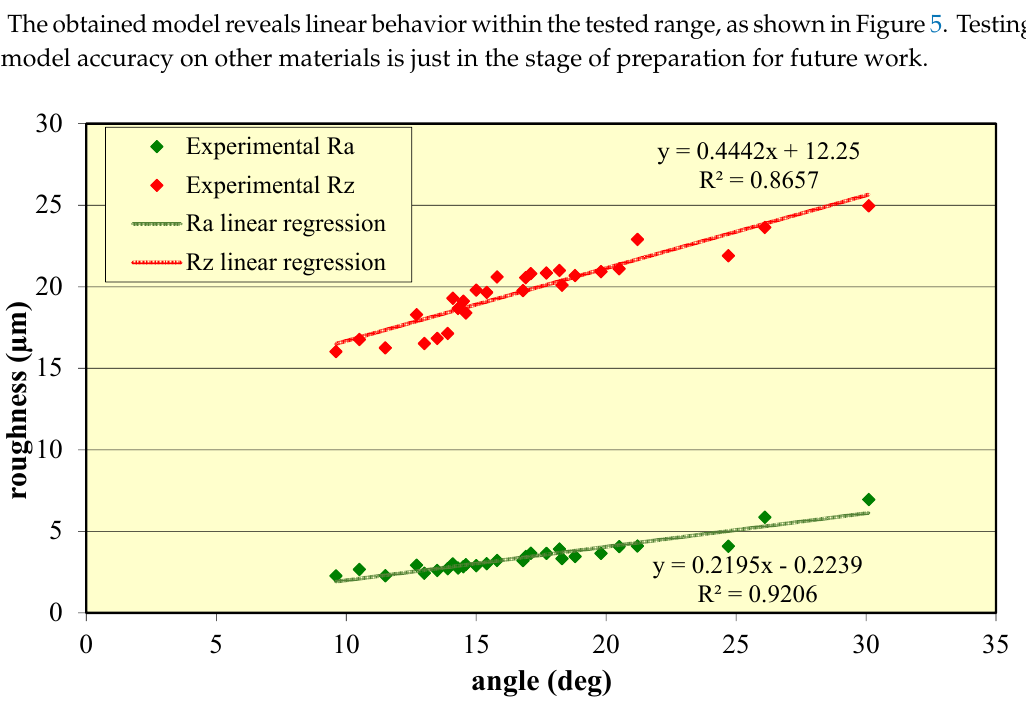
Figure 5. Roughness dependence on traverse speed with linear regression (typical graph).